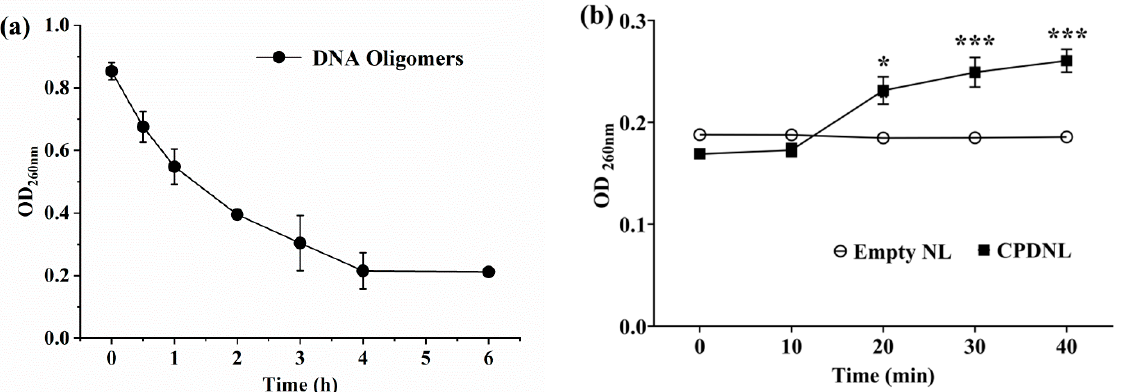
Figure 3. Enzyme activity of CPDNL. ( a ) Absorption at 260 nm during the generation of CPD substrates; ( b ) absorption at 260 nm after the addition of empty NL and CPDNL. Empty NL: nanoliposomes without CPD photolyases; CPDNL: nanoliposomes of CPD photolyases. Data represent means ± SEM. * p < 0.05 and *** p < 0.001 compared to empty NL.